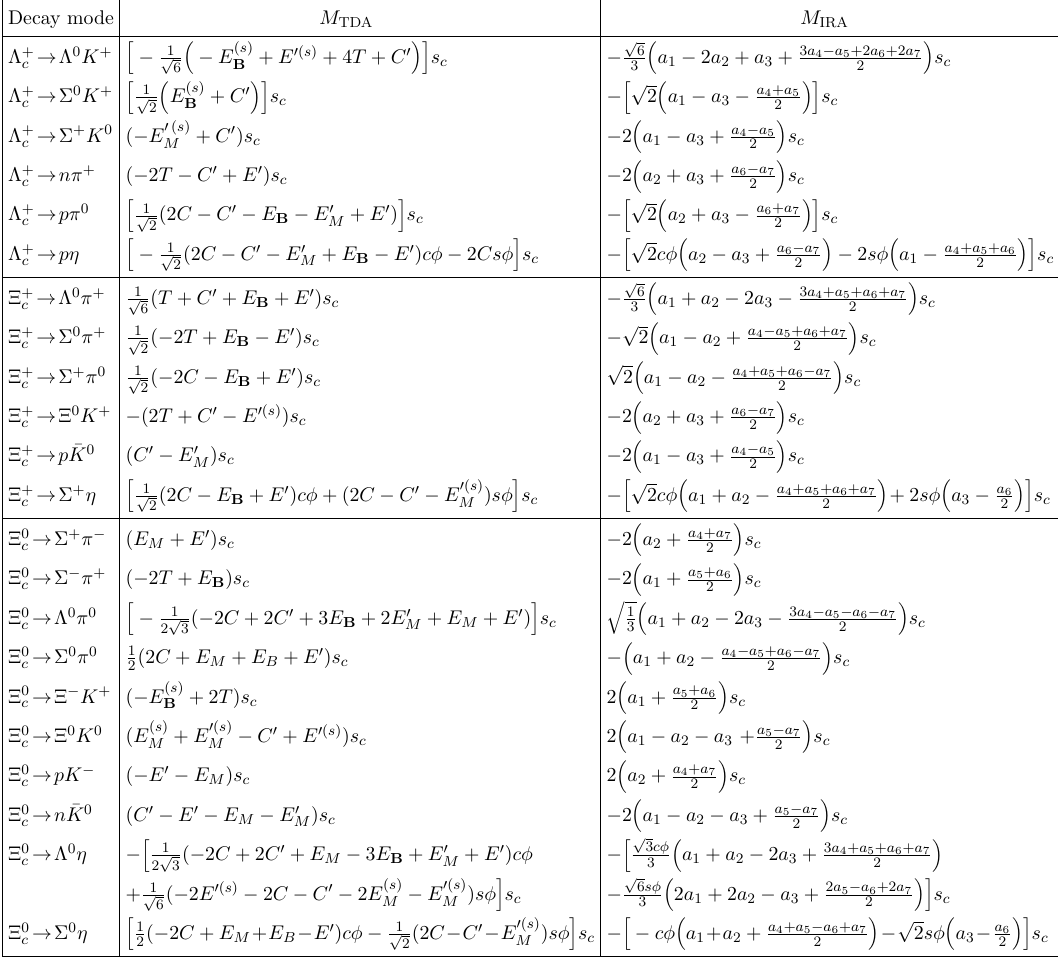
Table 2 . Singly Cabibbo-suppressed (SCS) amplitudes in the expansions of M TDA and M IRA